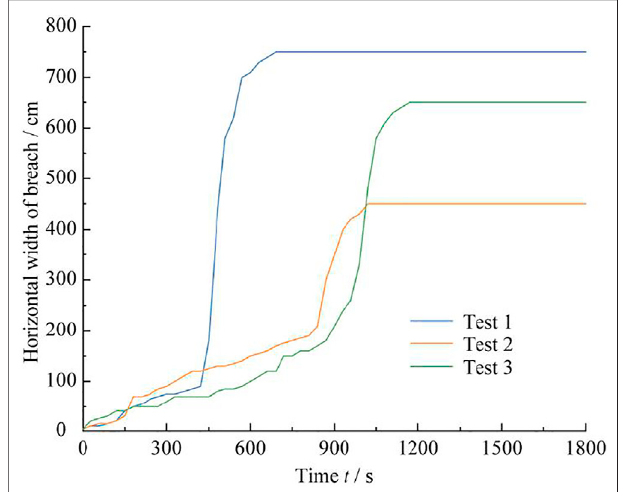
FIGURE 8 | Horizontal expansion of breach at downstream of dam